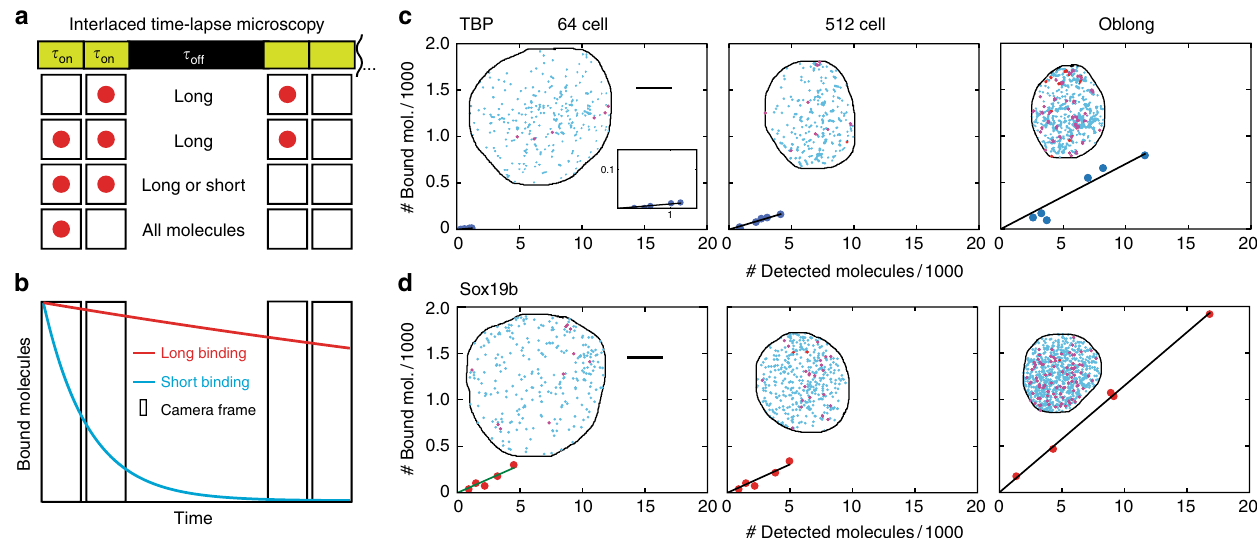
Fig. 4 mEos2-TFs bind according to the law of mass action. a Scheme of interlaced time-lapse microscopy. Red spheres indicate a detected mEos2-TF molecule. τ on : time laser is on, τ off : time laser is off. b Schematic decay of visible fl uorescence over time for the short (blue) and the long (red) bound fraction of molecules. c , d Number of molecules classi fi ed as bound compared to all detected molecules at the indicated stages. Every dot represents one embryo injected with c mEos2-TBP and d mEos2-Sox19b. The panel includes in total 53504 molecules from 5 embryos (64-cell stage) and 6 embryos (later stages) for mEos2-TBP and 76407 molecules from 5 embryos for mEos2-Sox19b. Insets : time-projection of all molecules within a nucleus classi fi ed as unbound (blue), short bound (magenta) and long bound (red). The scale bar is 5 µ